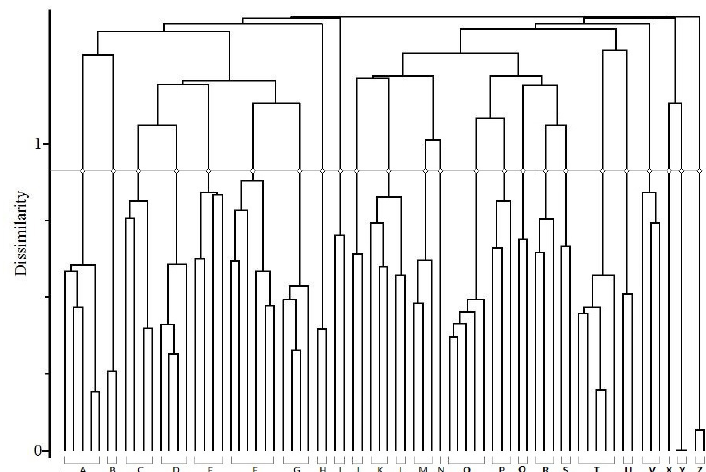
Figure 3. Dendrogram resulting from the cluster analysis of relevés. A, Riccia glauca comm.; B, Botrydietum granulati ; C, Rumici maritimi-Ranunculetum scelerati ; D, Callitrichetum palustris ; E, Helosciadietum nodiflori ; F, Filaginello uliginosae- Veronicetum peregrinae ; G, Limosella aquatica comm.; H, Charetum vulgaris ; I, Isoëtetum duriei ; J, Polygono salicifolii- Phragmitetum comunis ; K, Typhetum angustifoliae ; L, Typho angustifoliae-Schoenoplectetum tabernaemontani ; M, Typhetum latifoliae ; N, Sparganium neglec tum comm.; O, Bidenti tripartitae-Polygonetum mitis; P, Galio elongati-Juncetum inflexi ; Q, Loto tenuis-Paspaletum paspaloidis ; R, Holoschoenetum vulgaris ; S, Holoschoenetum vulgaris var. with Juncus inflexus ; T, Polygono lapathifolii-Xanthietum italici ; U, Salix alba and Populus alba comm.; V, Tamarix africana comm.; X, Ceratophylletum demersi ; Y, Potamogetonetum nodosi ; Z, Lemnetum gibbae